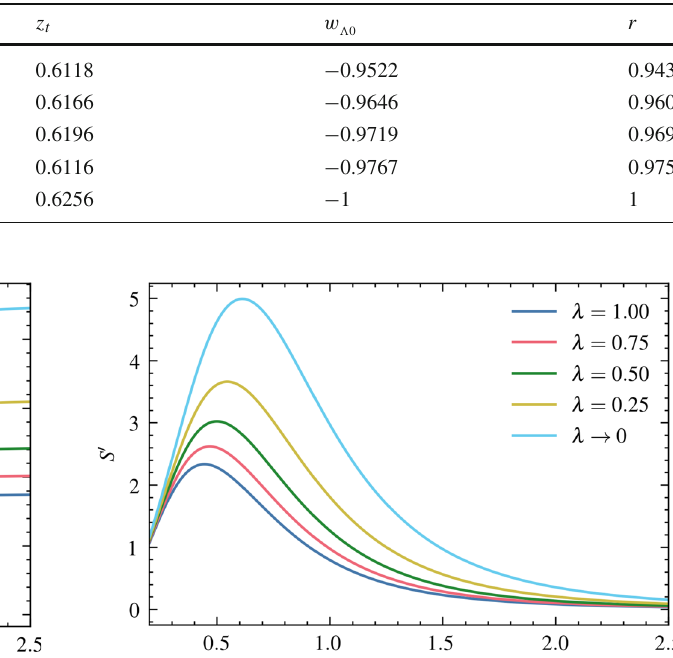
Table 3 Estimates of various parameters for different values of λ ∈ [ 0 , 1 ] with (cid:12) = 0 . 315 and H = 67 . 4 km/s/Mpc [78]. Here λ is the m 0 0 model parameter, q 0 is the present value of deceleration parameter, z t is